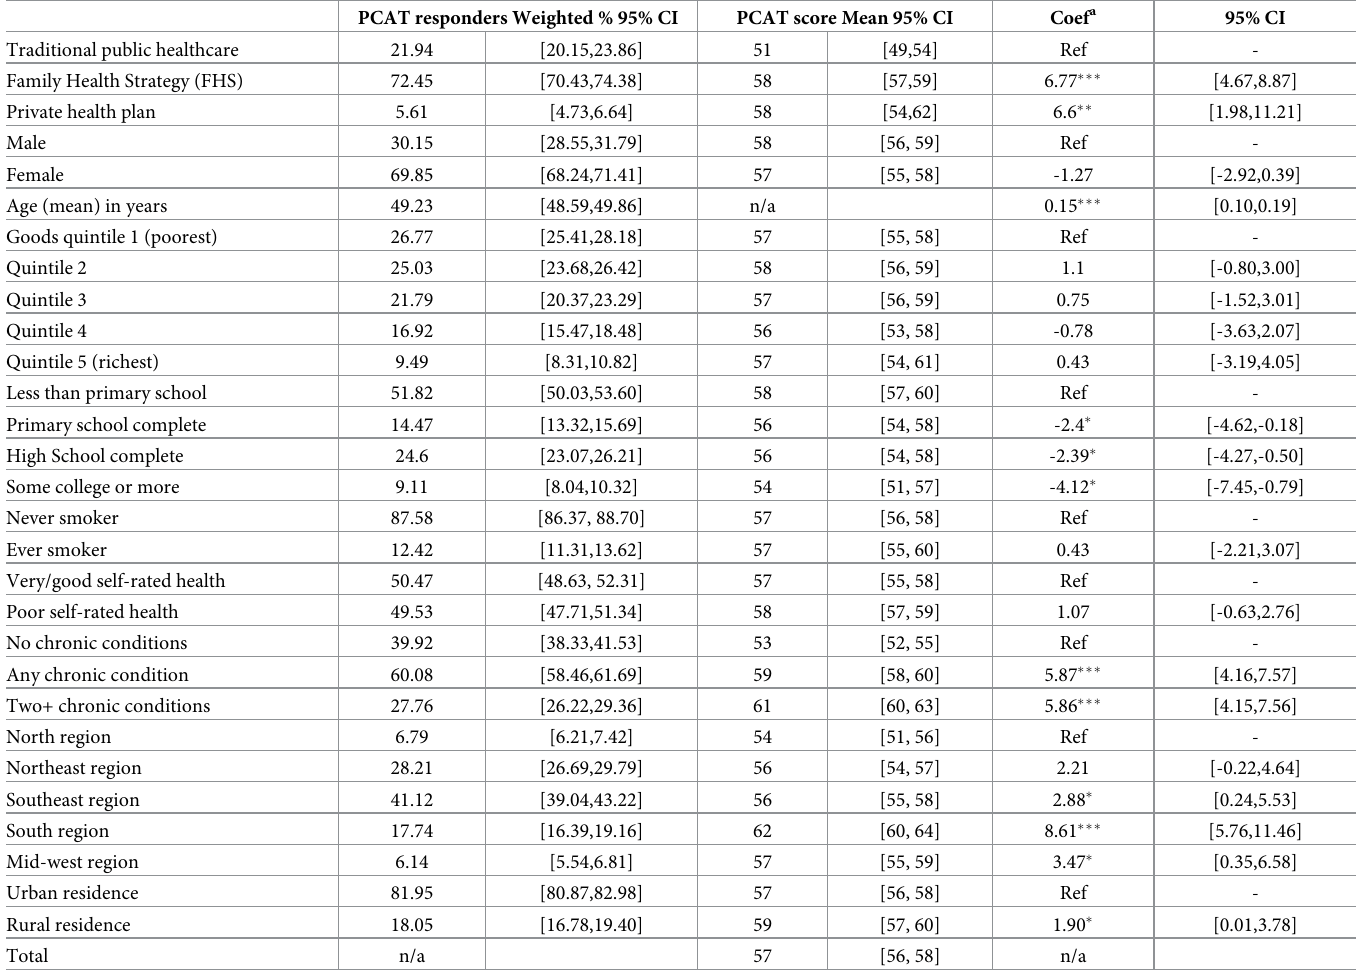
Table 2. Distribution of respondent characteristics, mean PCAT score and bivariate analyses, PNS